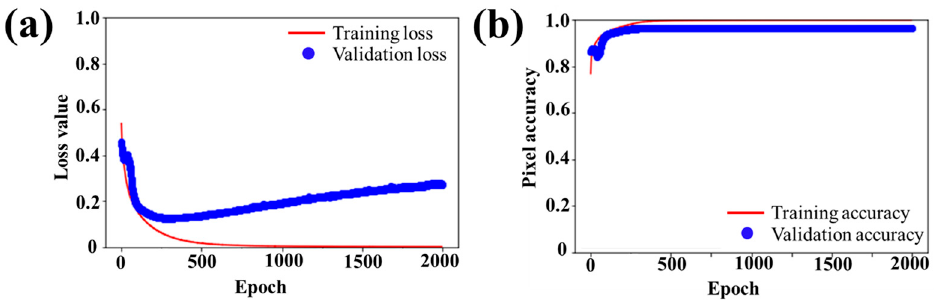
Forests 2022 , 13 , x FOR PEER REVIEW Figure 4. Training and validation loss and pixel accuracy values of U-Net classification with respect to forest and non-forest areas. ( a ) is training and validation loss curve, and ( b ) is pixel accuracy curve. Table 1. Summary of U-Net performance of each epoch .